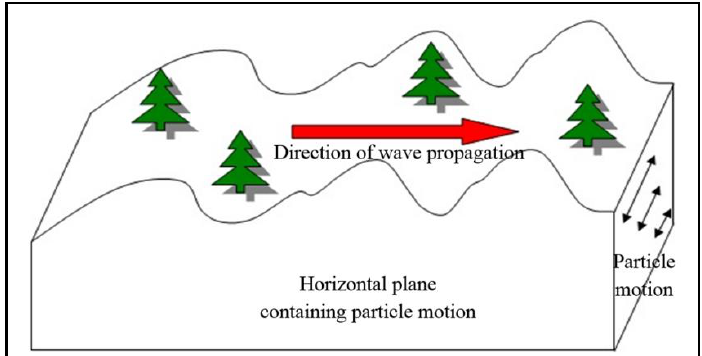
Figure 7. Particle motion of Love waves in horizontal plane.